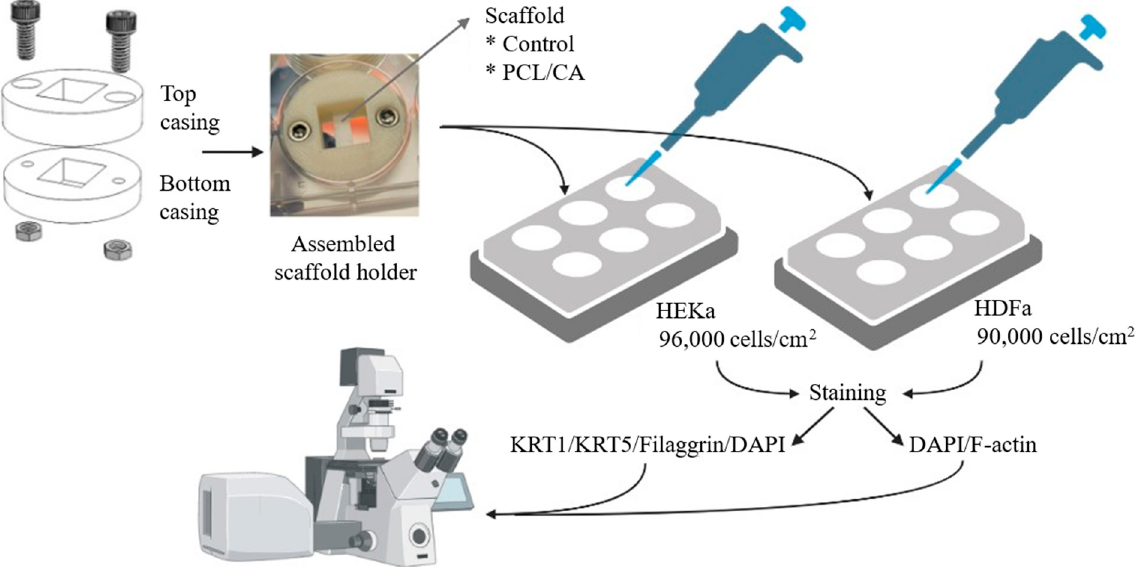
Figure 1. The roadmap to in vitro testing of the present study (the figure was created with BioRen-